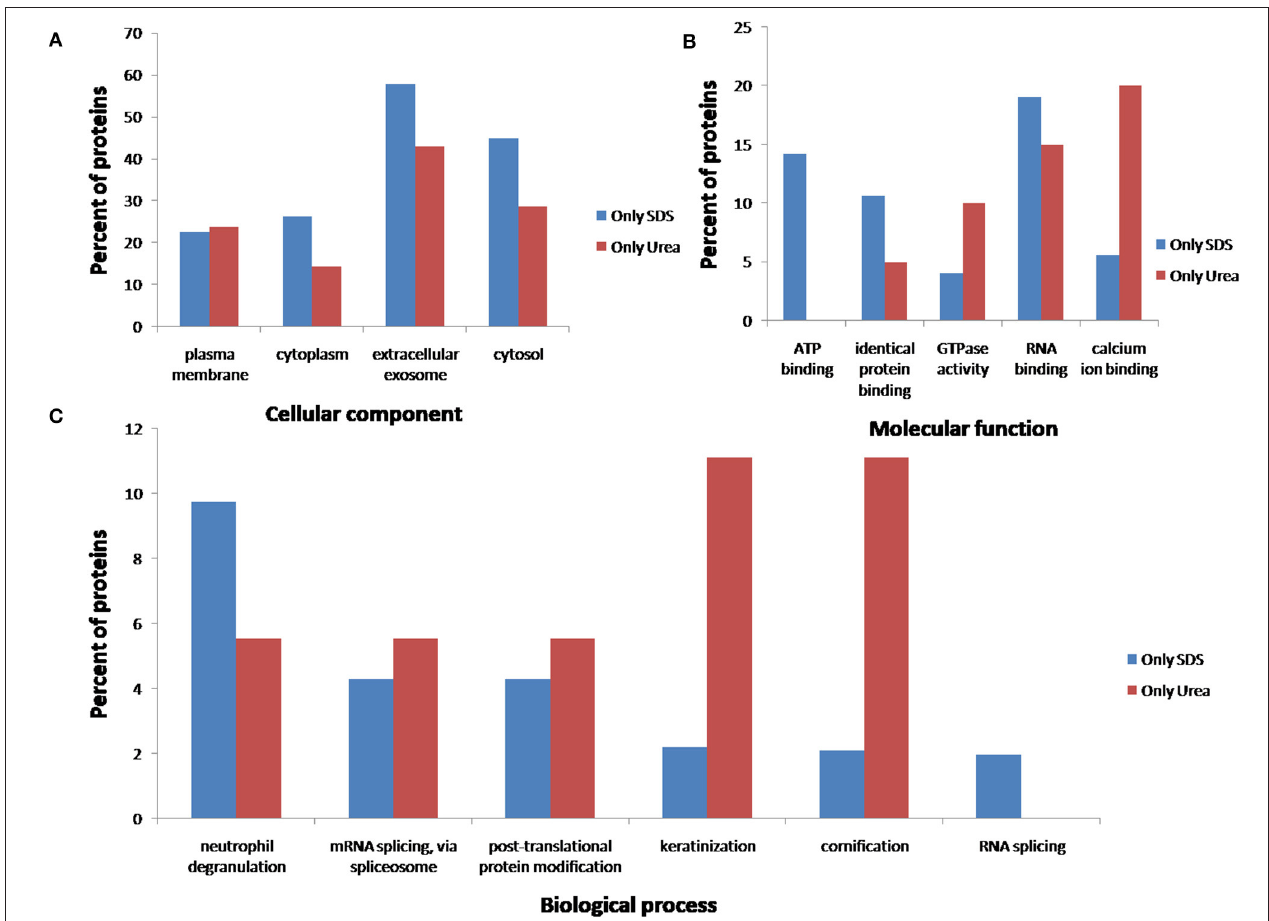
FIGURE 8 | Functional classification of the 896 and 21 unique proteins identified after the extraction with the five SDS-containing buffers [ buffer 1 (Tris-SDS LB), buffer 3 (Tris-SDS-DTT-Glycerol LB), buffer 4 (citrate-SDS LB), buffer 5 (SDS-LB), and buffer 6 (RIPA LB)] (blue bars) and the urea-containing buffer [ buffer 2 (urea LB)] (red bars), respectively, according to their (A) cellular component, (B) molecular function, and (B) biological process, using the FunRich